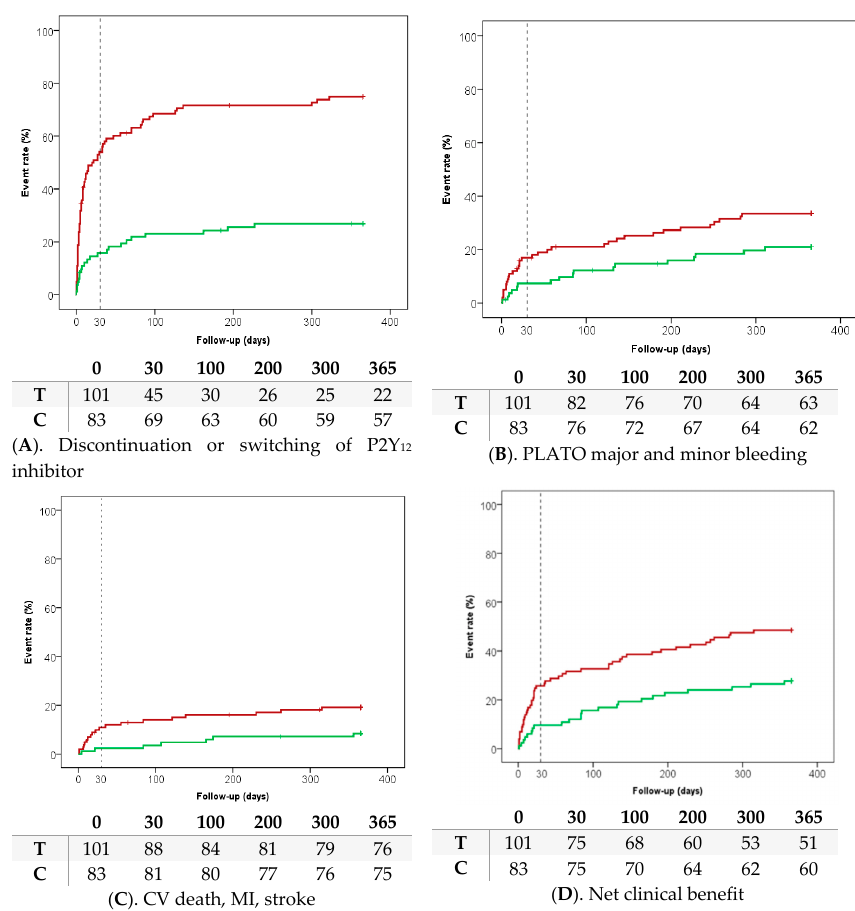
Figure 1. Red patients randomised to ticagrelor (T), green patients randomised to clopidogrel (C). ( A ) Discontinuation or switching of P2Y12 inhibitor; ( B ) PLATO major and minor bleeding; ( C ) CV death, MI, stroke; ( D ) Net clinical benefit.